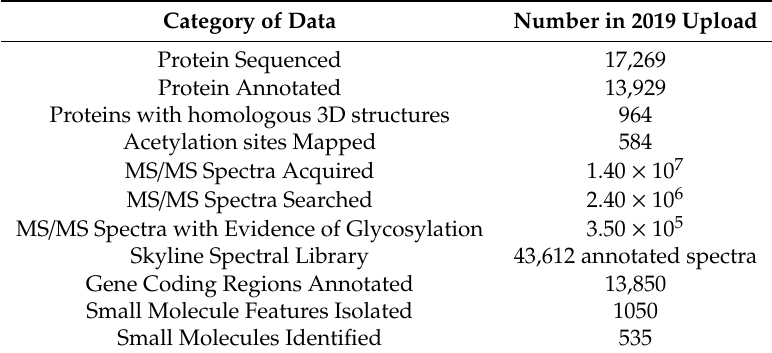
Table 1. An overview of the progress to